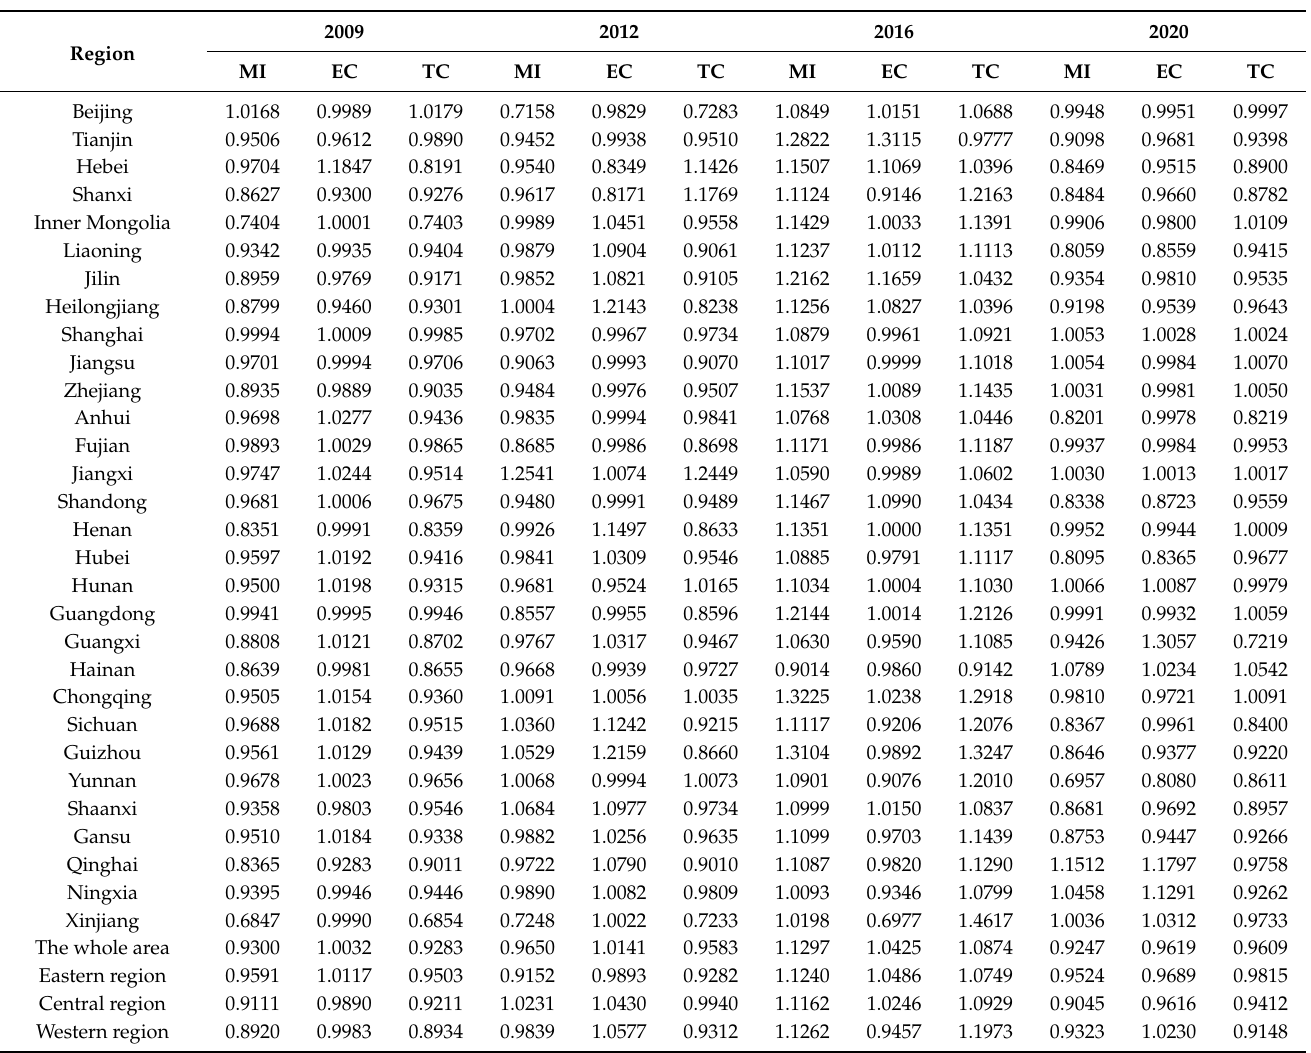
Table 3. MI index, EC index and TC index of Chinese